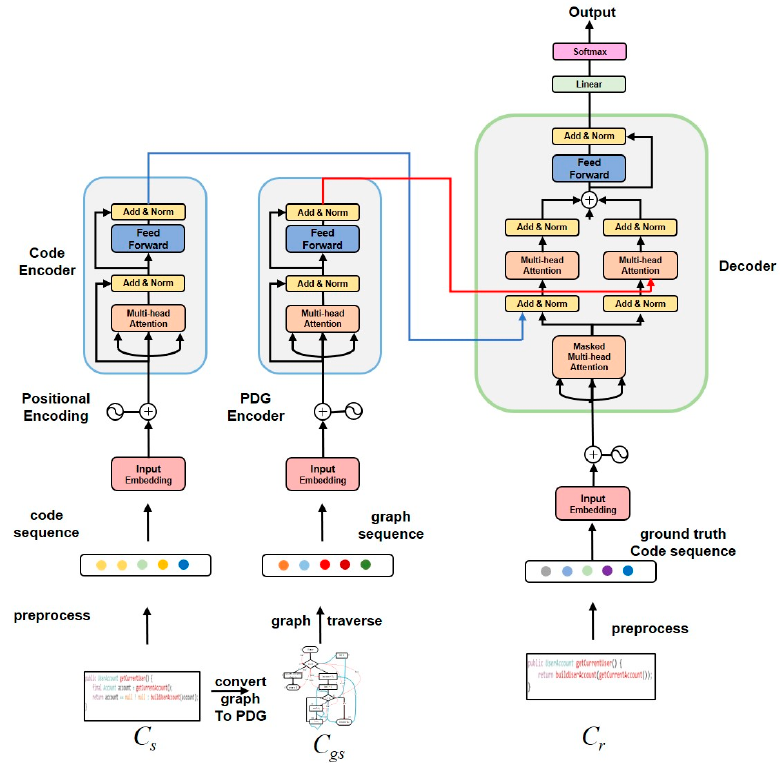
Figure 6. Task 1 corresponds to the model framework crBERT1.